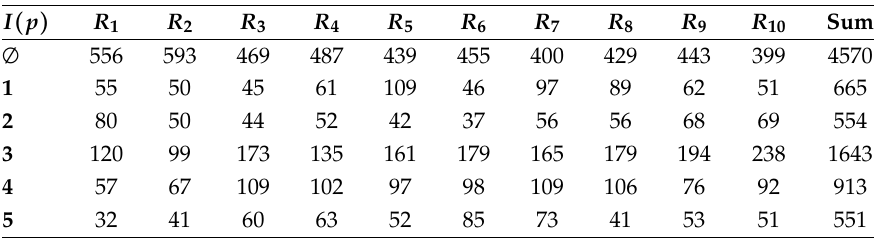
Table 6. Total seeding point health index I ( p ) counts for the study parcel divided by plowing rows R 1 , . . . , R 10 from top to